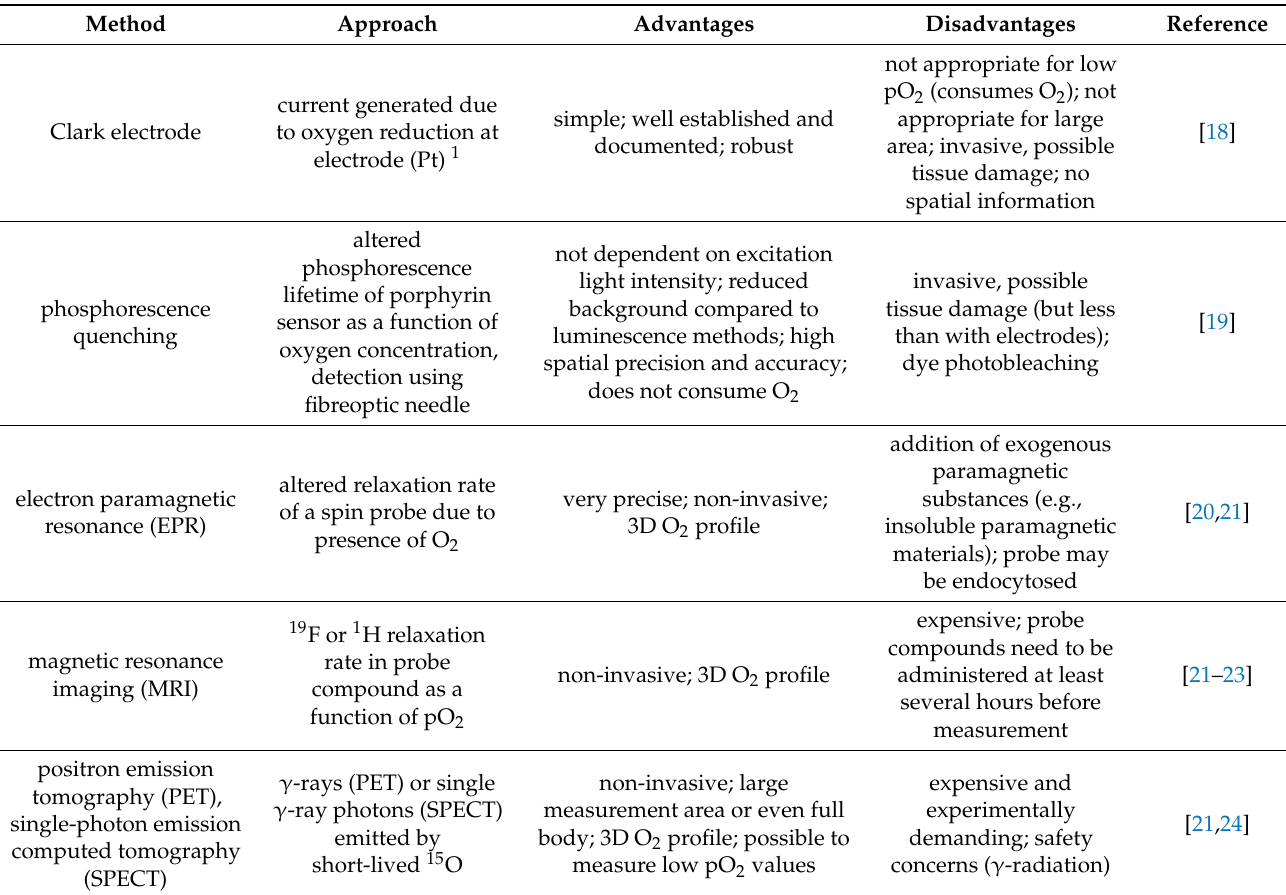
Table 1. The most important methods for quantitative measurement of the partial pressure of O 2 in